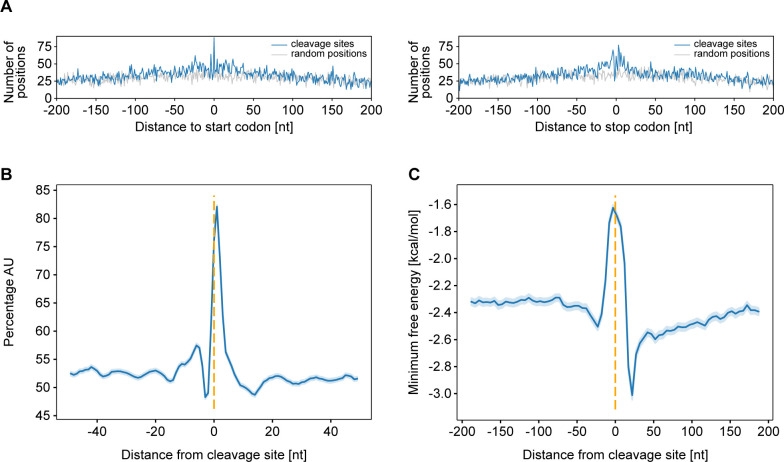
Position and characteristics of RNase E cleavage sites.TIER-seq was performed as described in Figure 1. (A) Frequency of RNase E sites or the same number of randomly selected genome positions dependent on their relative position to start codons (left) and stop codons (right). (B) AU content around the RNase E cleavage sites. The 95% confidence interval is indicated in light blue. (C) Degree of RNA structure around RNase E cleavage sites. Minimal folding energy (MFE) was calculated in five nt steps for each 25 nt window. The 95% confidence interval is indicated in light blue.